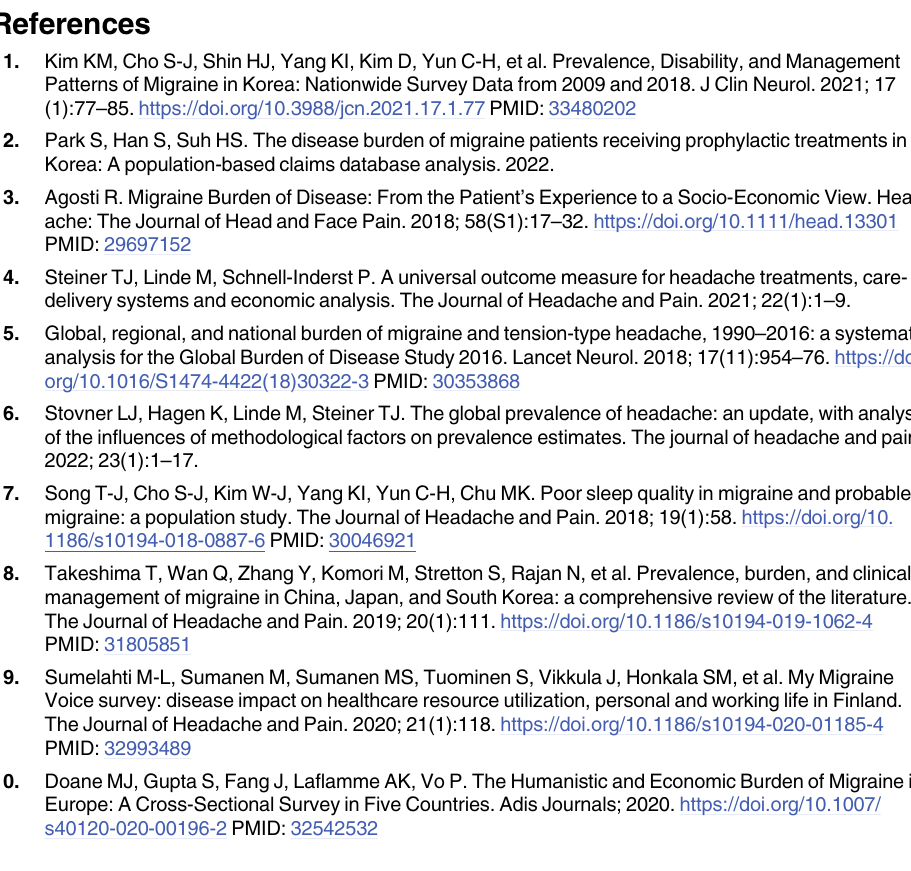
S1 Table. Demographics of analgesic use subgroups. Abbreviations: SD, Standard deviation. Data are N(%) values. The exchange rate of Korean won to the US dollar was 1086.3 Korean won/US dollar in 2020. � High school graduation means ‘elementary, middle, and high school graduation’, and � College degree means ‘having college degree or